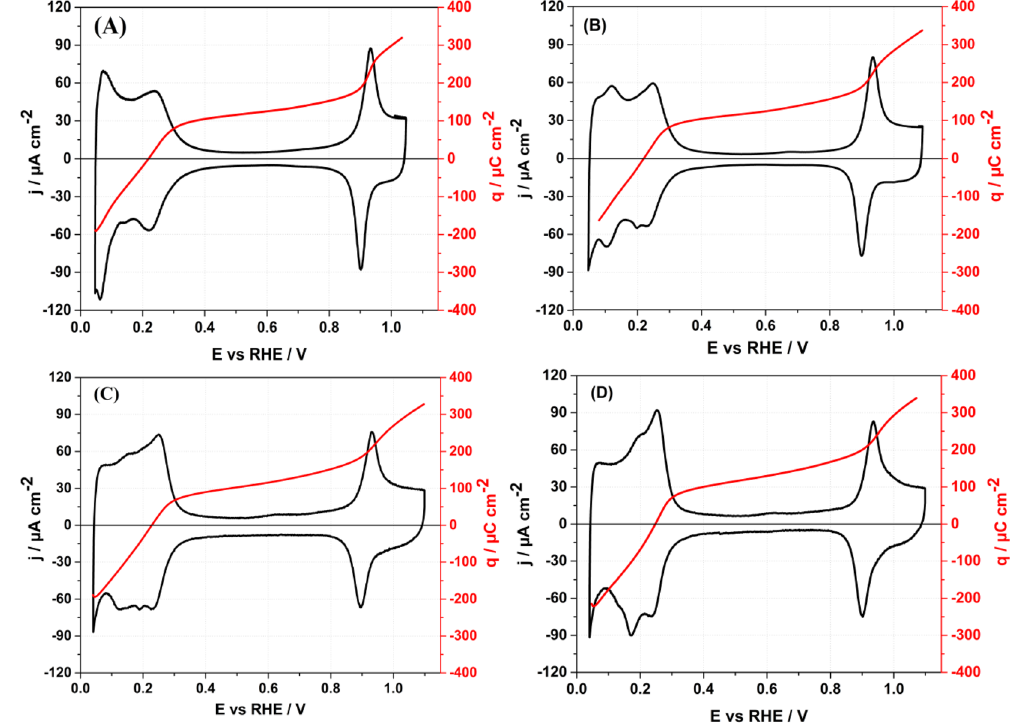
Figure 8. Voltammetric profiles of Ir(111) at ( A ) pH = 1, ( B ) pH = 2, ( C ) pH = 3, ( D ) pH = 4. Solutions employed are described in Fig. 1(A) and (B). Scan rate 50